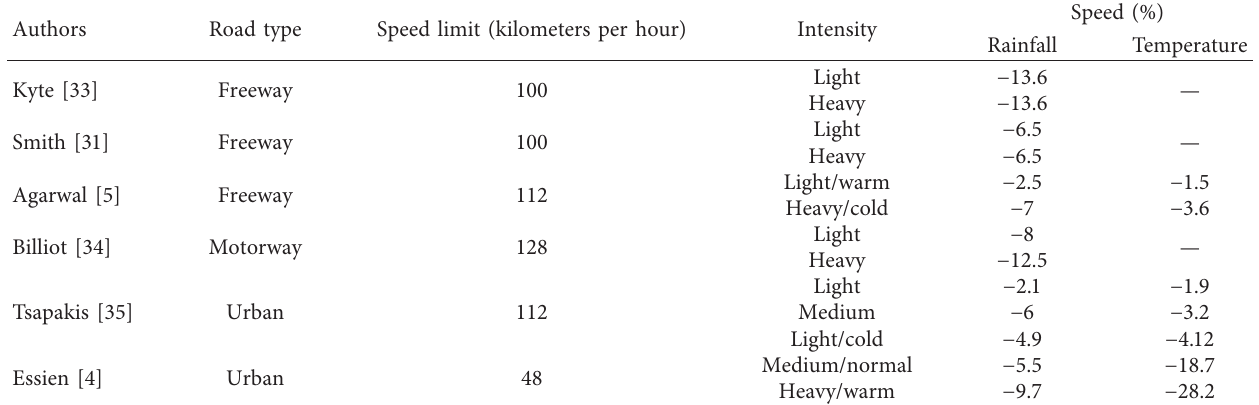
Table 1: Studies that have worked on weather conditions and traffic